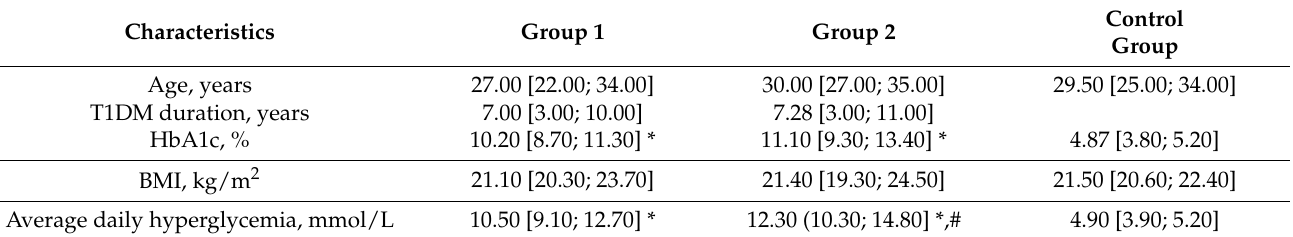
Table 1. Clinical characteristics of the men with T1DM (Me, [Q1; Q3]). Characteristics